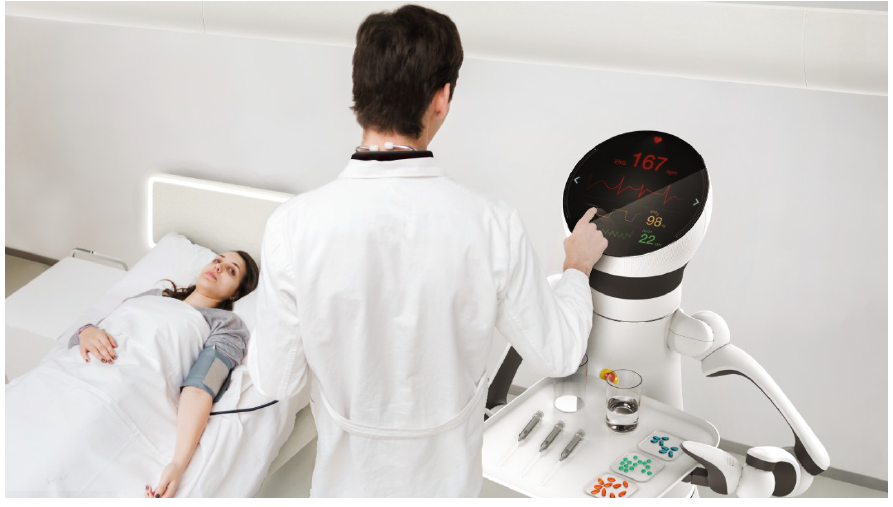
Figure 5. Care-O-bot 4